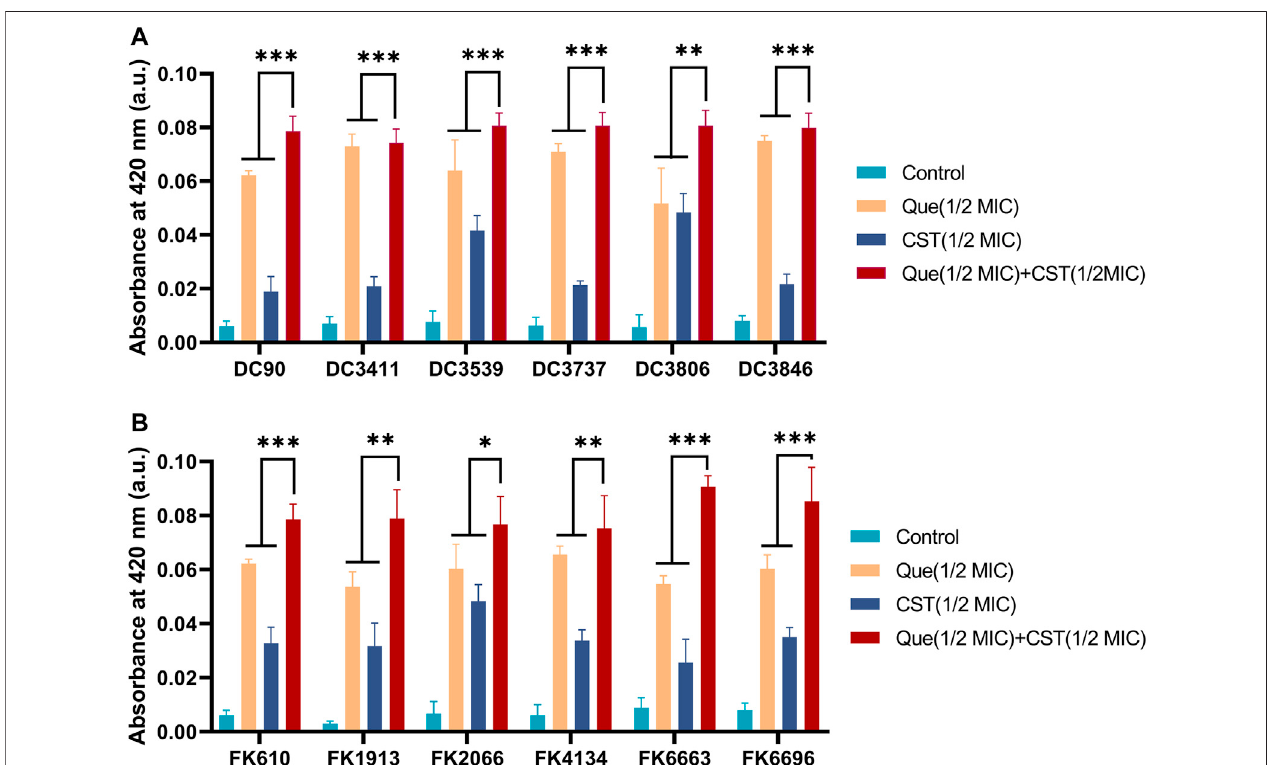
FIGURE 4 | Combination of quercetin and colistin contributes to the damage of bacterial cell membranes and the leakage ofbacterial β -galactosidases. Quercetin andcolistincombinetodisruptbacterialcellwallintegrityof E.coli (A) and K.pneumoniae (B) bydetectingthereleaseofintracellular β -galactosidase.Thechartindicates that an increase for β -galactosidase in the medium after exposure to the speci fi ed compound. The results are shown as the mean and standard deviation of three independent experiments. ns stands for not signi fi cant, * p < 0.05, ** p < 0.01, *** p < 0.001, determined by the Student ’ s t -test.